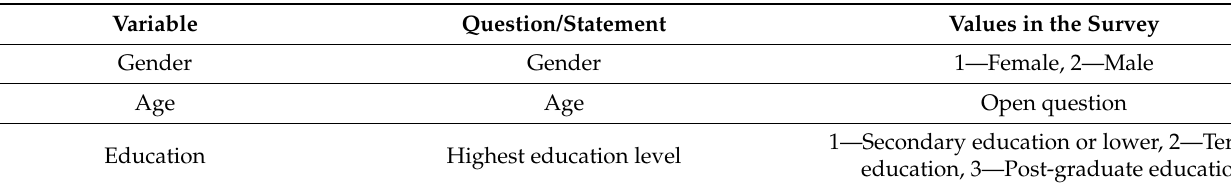
Table A1. Survey questions and